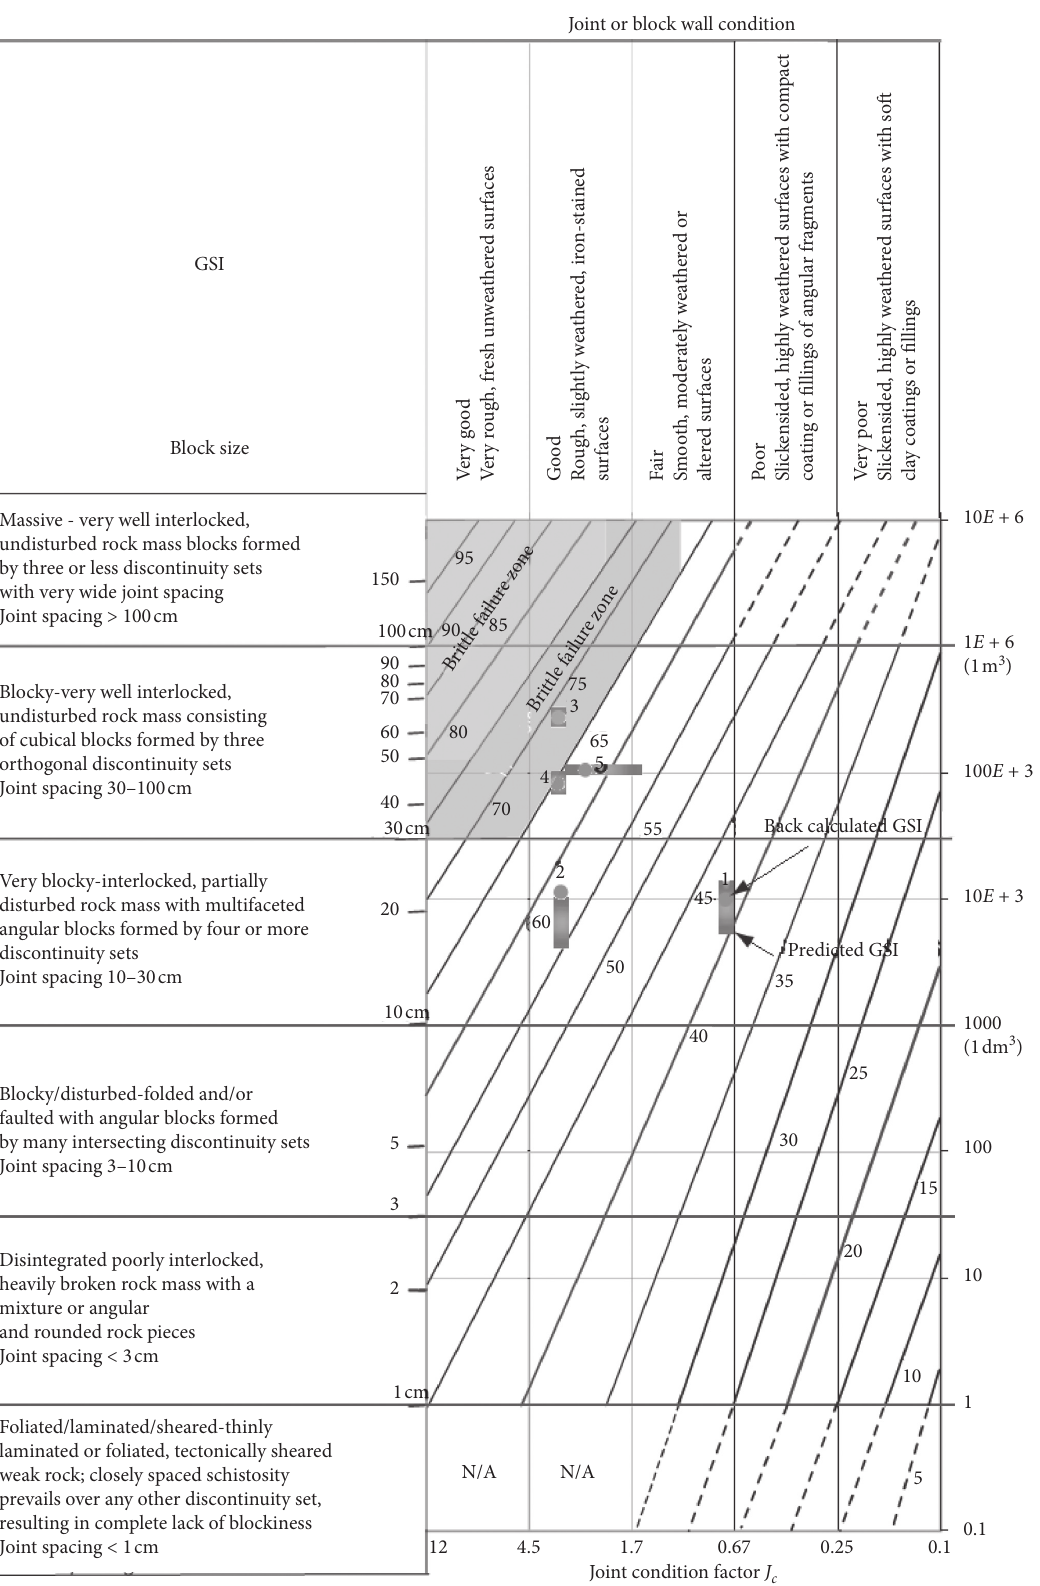
Figure 7: GSI quantification chart